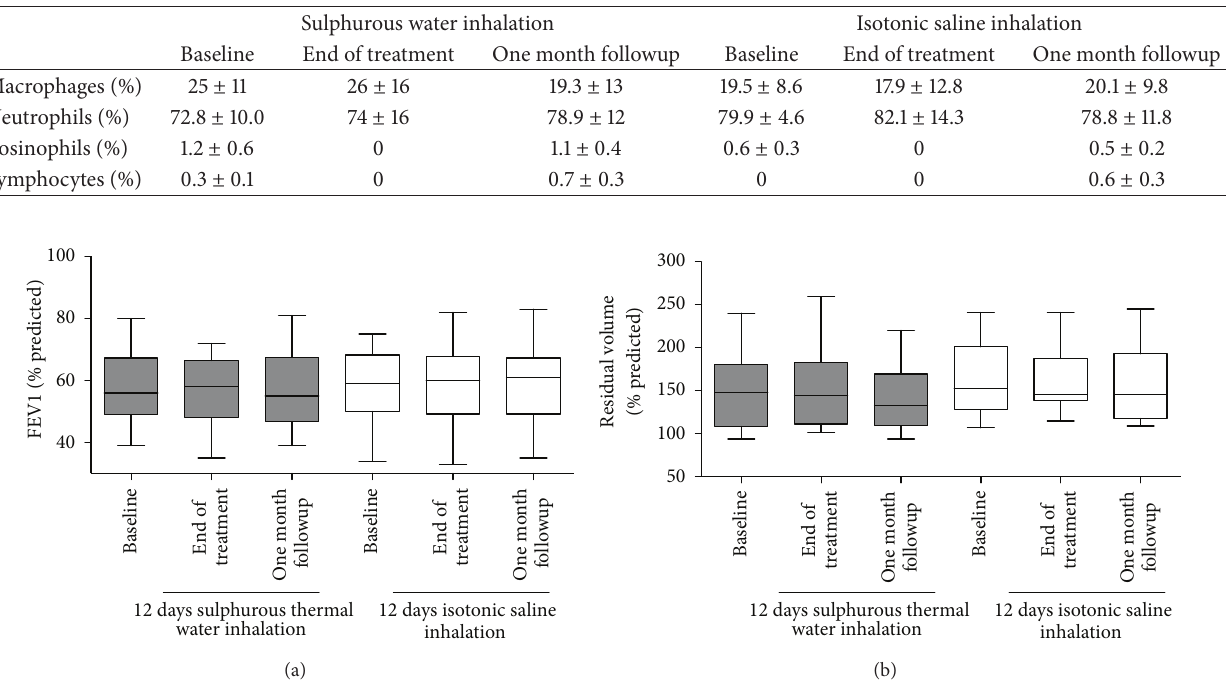
Figure 3: Lung function parameters (postbronchodilator FEV1 and residual volume) in COPD patients at the baseline, at the end of the inhalation treatment, and one month after the end of the